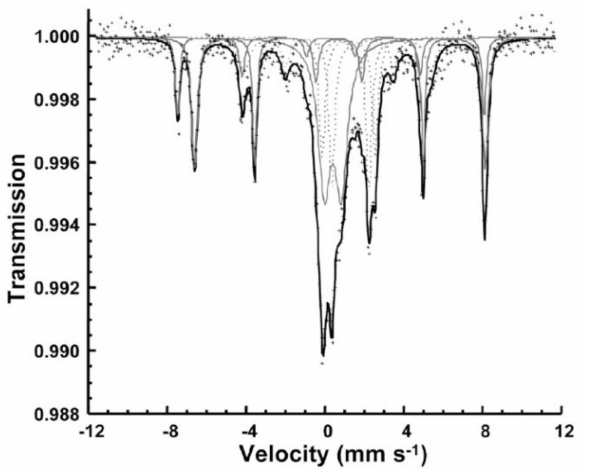
Figure 3. Room temperature Mössbauer spectrum of carbonaceous chondrite Tagish Lake C2-ung. Indicated components are the result of the fit. Adapted from Reference [42].